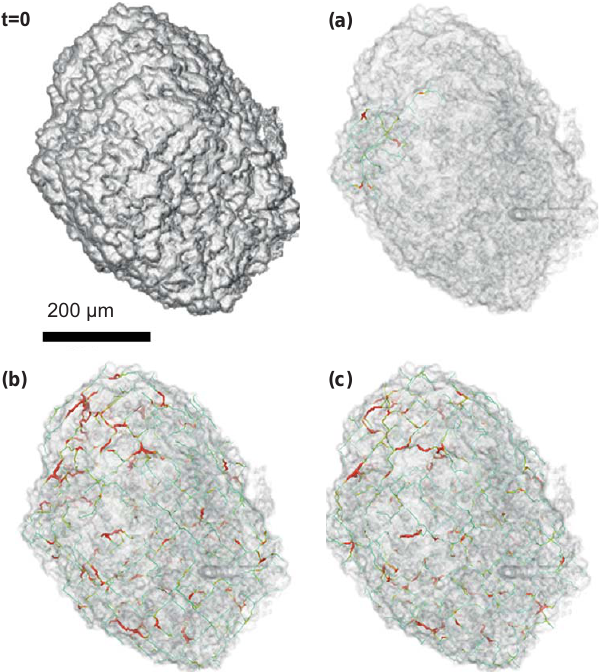
Figure 7. A 3-D render of a single grain showing the progression of saturation. The images show the evolution from first contact with the fluid to a steady saturated state over three scans. The colours and the size of tubes representing the pore network correspond to the lo- cal volume of the fluid within the pores: thick red tubes represent the higher local volume; thin blue tubes represent lower local sat- uration. Data are from sample LD_1, showing the dry scan ( t = 0) and the final frames of (a) scan 1 (continuous), (b) scan 2 (G1), and (c) scan 3